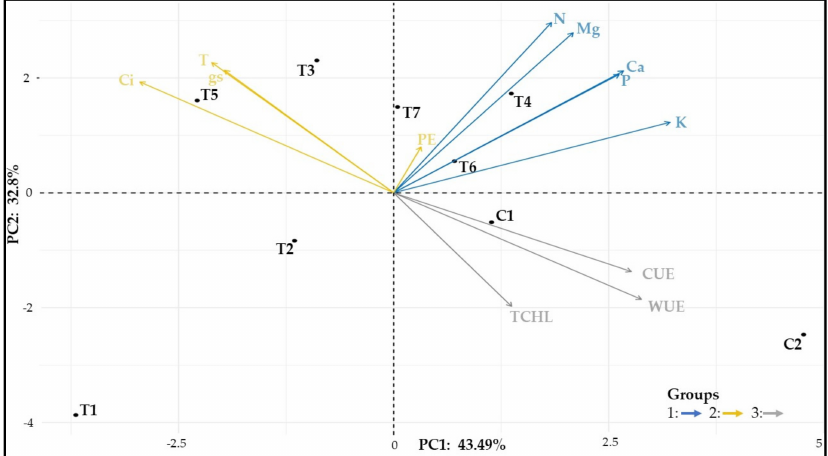
Figure 12. Principal component analysis with physiological variables. Ci: internal CO 2 concentra- tion, T: leaf transpiration, gs: stomatal conductance, PE: photosynthetic efficiency, WUE: water